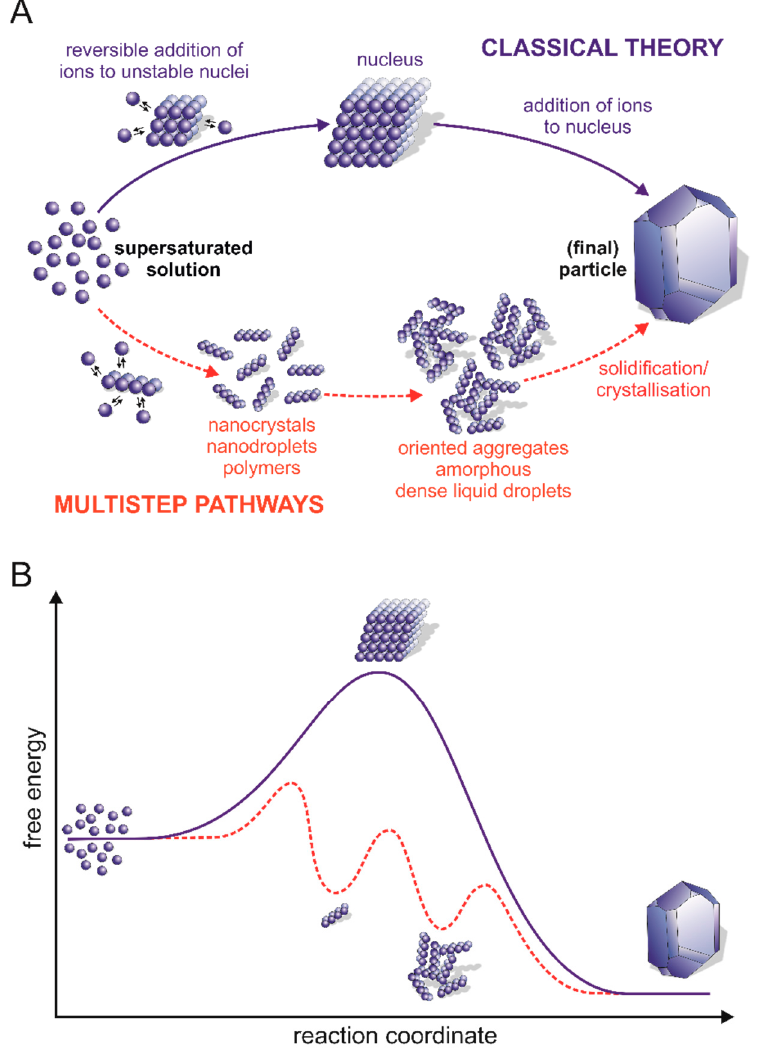
Figure 2. Classical and multistep nucleation pathways. ( A ) Schematic presentation of events occurring during the formation of crystals from the bulk liquid to crystalline pathways according to classical theory (blue) and multistep pathways (red). ( B ) Comparison of free energy along the pathway of crystal nucleation following the classical nucleation mechanism (blue) and multistep pathways (red) [20,108].